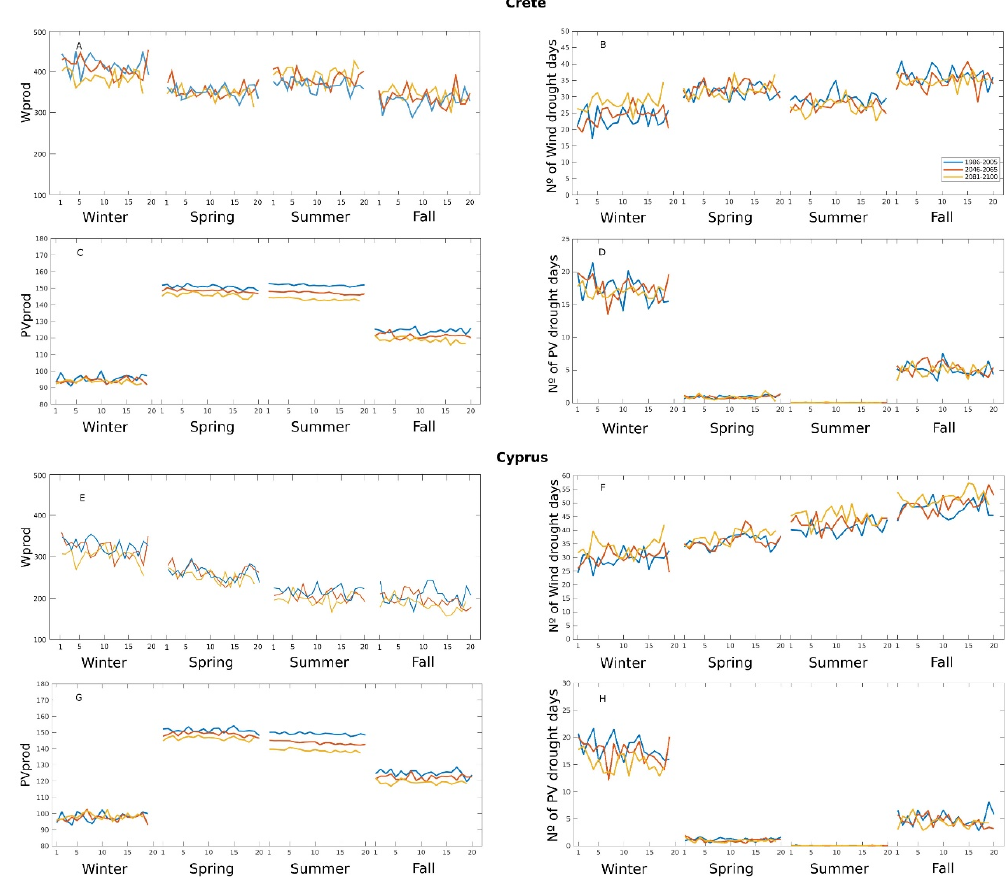
Figure 4. Seasonal time series for the different time periods, indicators computed for Crete ( A – D ) and Cyprus ( E – H ) for the RCP8.5 scenario. Depicted indicators are: wind productivity ( A , E ), wind productivity droughts ( B , F ), PV productivity ( C , G ) and PV productivity droughts ( D , H ). Productivity values are given in kWh / kW, in monthly average for each season, while productivity droughts are given in the number of drought days per season. In this figure, the control (1986–2005) appears in blue, the near-future period (2046–2065) in red and the distant-future period (2081–2100) in yellow.